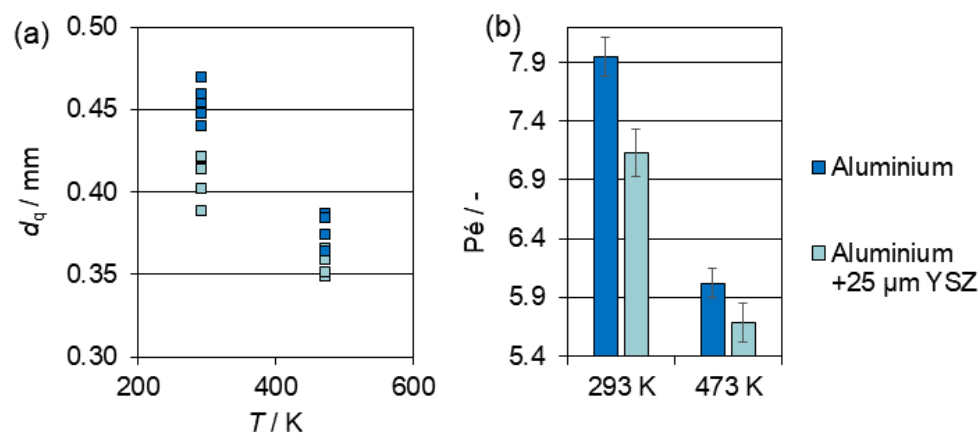
Figure 6. ( a ) Measured sidewall quenching distances for a propane/air mixture ( Φ = 1.2) at 0.63 bar. ( b ) Derived Péclet numbers.